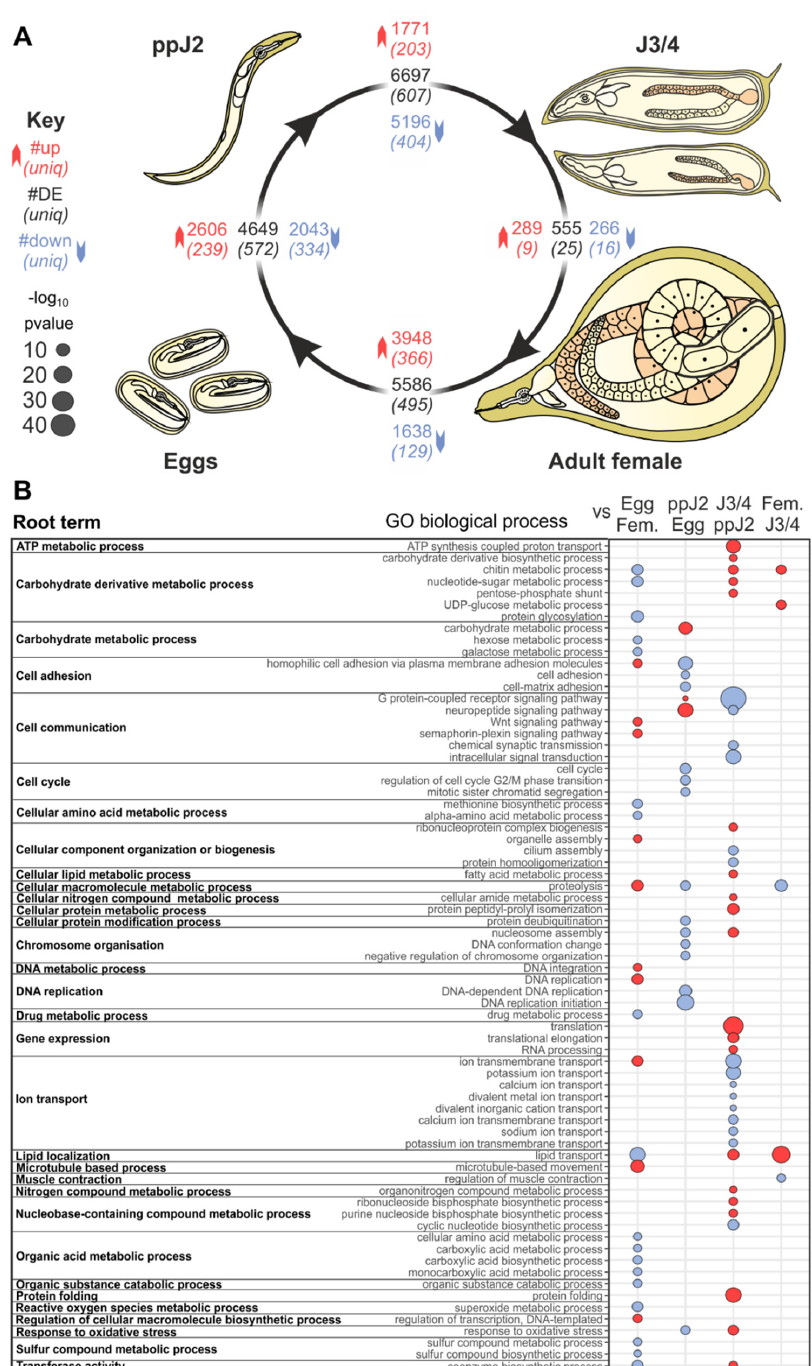
Figure 1. Distinct patterns of 12,461 differentially expressed genes (DEGs) and gene ontology (GO) term enrichment between the life stages of M. incognita. ( A ) Representation of the nematode life cycle. At each transition between stages (black arrows), the total number of DEGs is indicated in black in the central box. Genes significantly upregulated and downregulated are indicated in red and in blue, respectively. The number of DEGs only at this transition is indicated in italics and parentheses. ( B ) The GO biological process terms significantly enriched in each transition are shown, grouped by their root terms. Bubble plots illustrate the most significant GO terms that were overrepresented (in red) and underrepresented (in blue) for each term. If no bubble is present, the representation of this term was not significantly different at that transition. Bubble size is calculated as − log10 (refined p -value), resulting in a p -value FWER threshold at